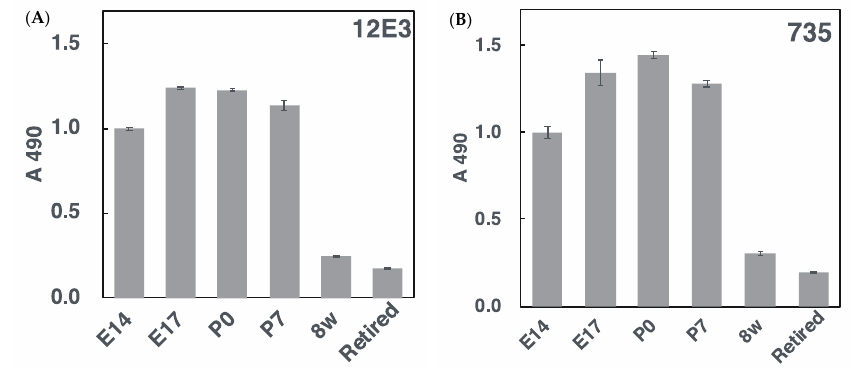
Figure 5. ELISA analysis of polySia–NCAM derived from mouse brains at different developmental stages. PolySia expression at different brain development stages (E14, E17, P0, P7, 8 w, and retired ( n = 1)) was analyzed by ELISA. Brain homogenates of six different stages (250 ng as protein) were immobilized onto the 96-well plate and blocked with 2% BSA. The wells were then incubated with 12E3 or 735 antibodies before or after Endo-N treatments. After color development, the subtraction of the Endo-N-treated well from the Endo-N-untreated well was performed. ( A ) and ( B ) show the activity of the 12E3 and 735 antibodies, respectively. Triplicated analyses were shown with error bar.